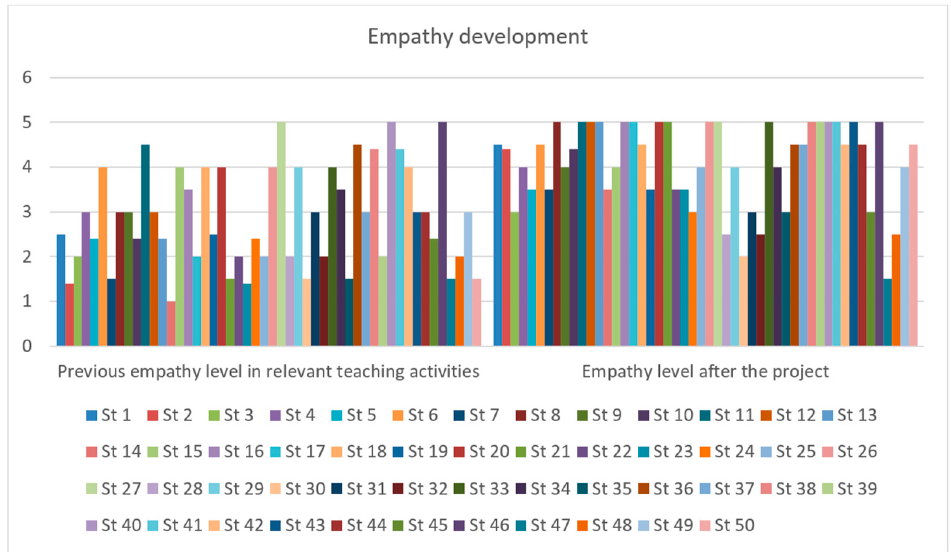
Figure 8. Comparative representation of 50 students’ empathy levels.